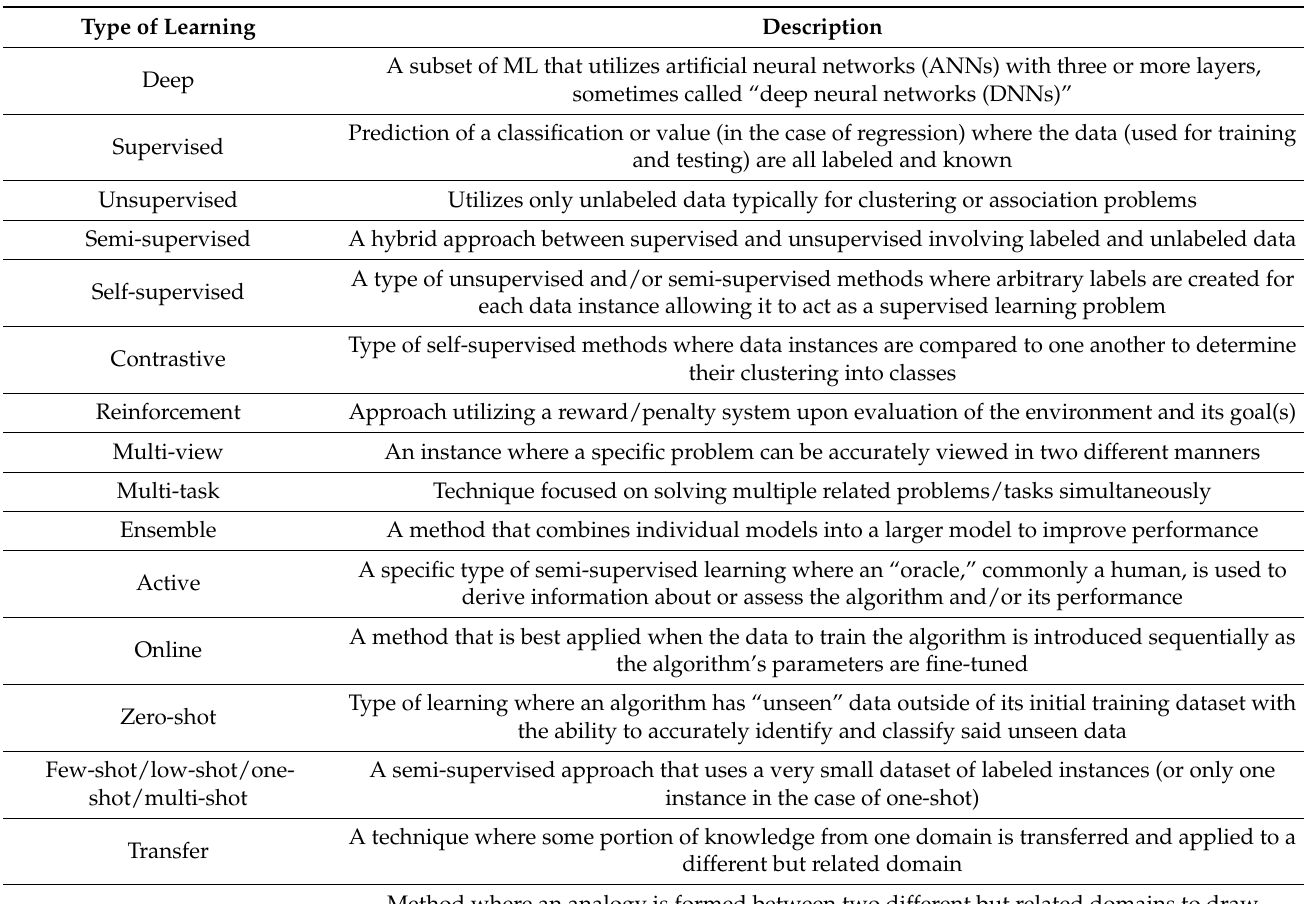
Table 2. Types of machine learning